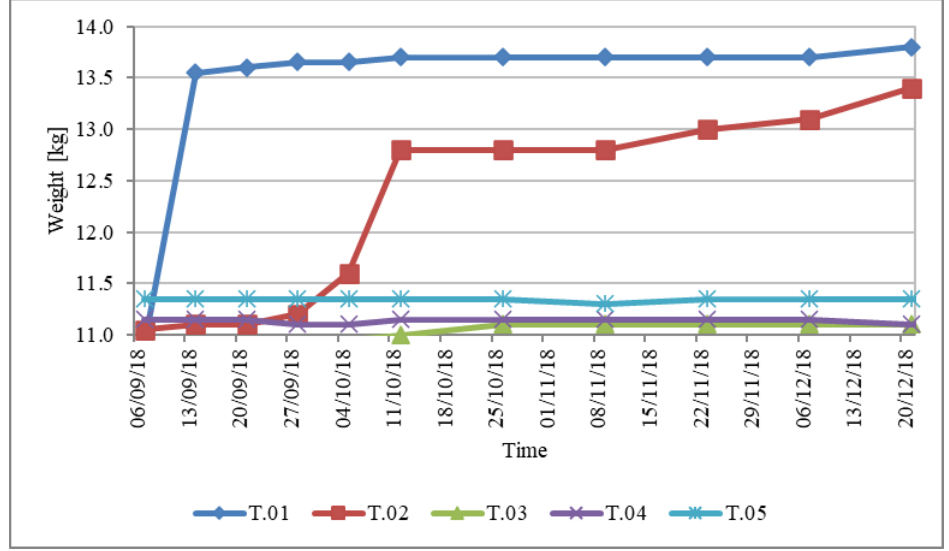
Figure 6. Weight-time absorption curves for the tuff column (T.).